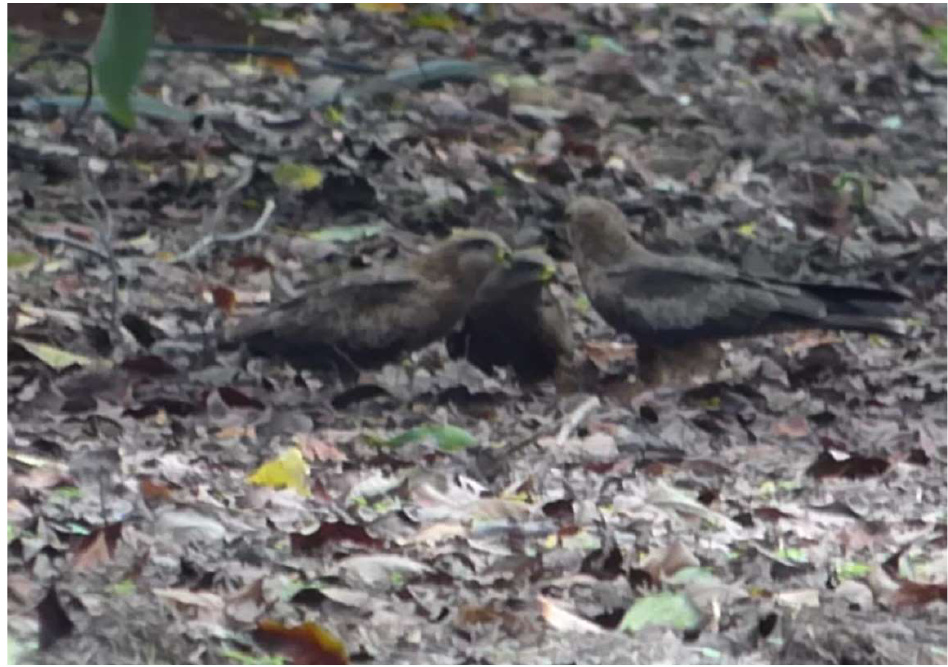
Figure 2. Three Black Kites consuming avocado flesh, Mareeba, Queensland, Australia. Photo: Jack Leighton.